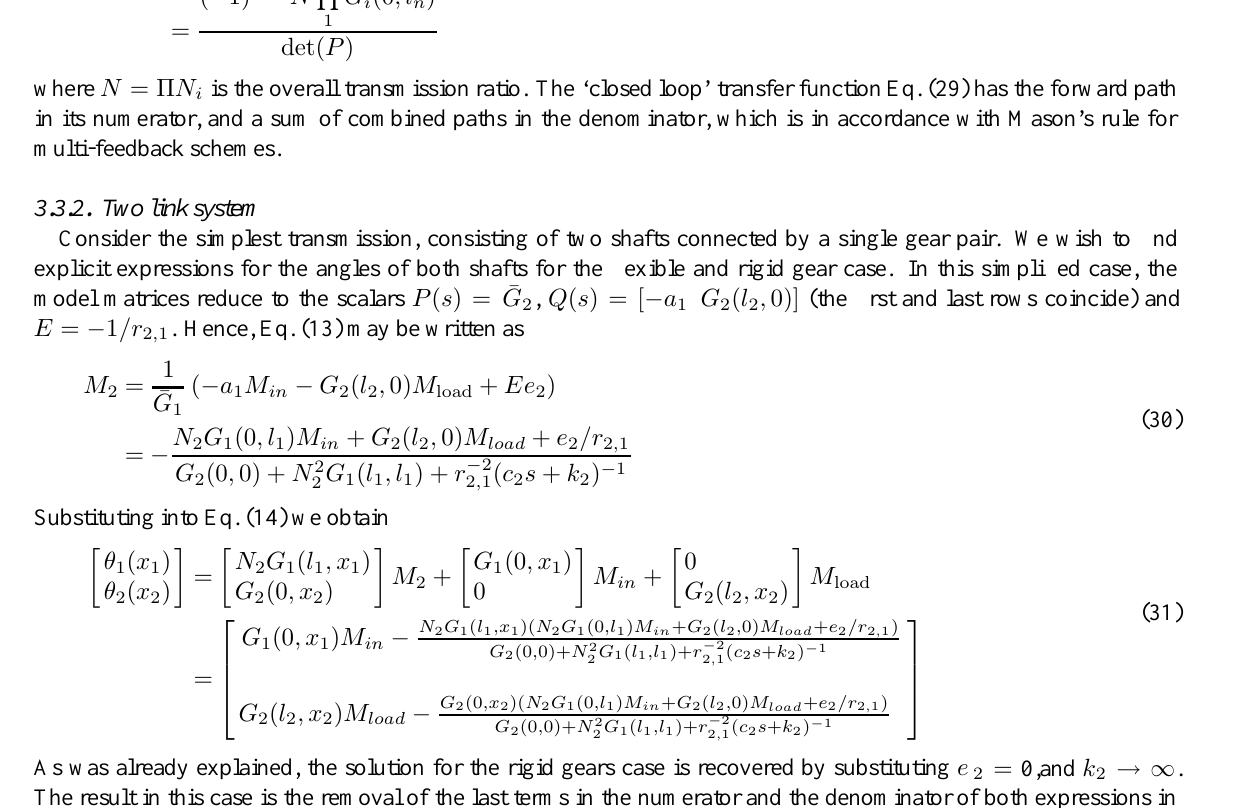
Fig. 8. A simulation scheme for G (0, l )